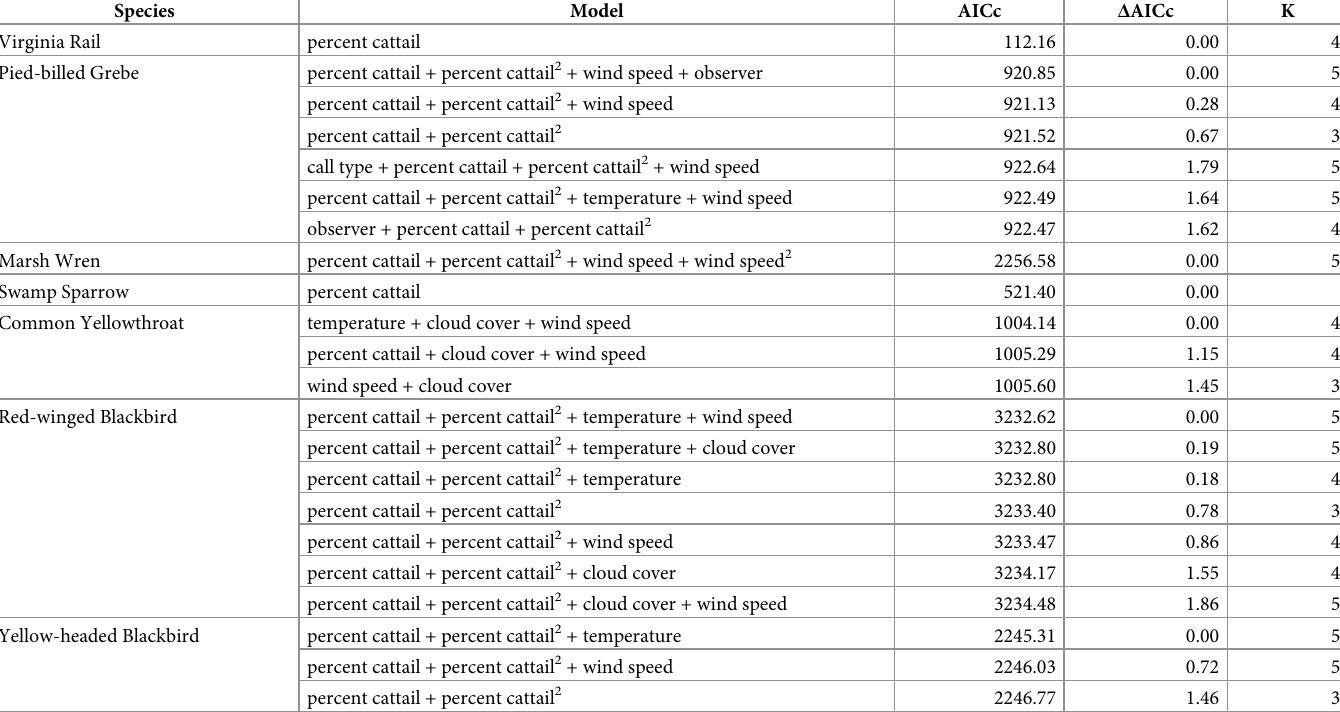
Table 2. Model selection results for detection probability for seven species of breeding marsh birds surveyed at shallow lakes in the Prairie Pothole Region of Iowa, summer 2016 and 2017. Species